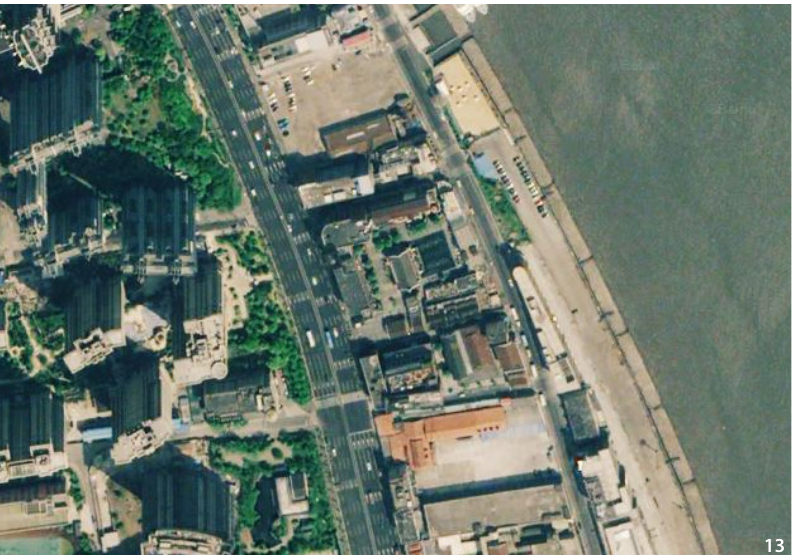
Figure 13 Satellite image of the Cool Docks (Source: Baidu Map).